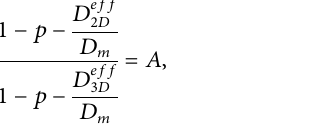
Frontiers in Materials |